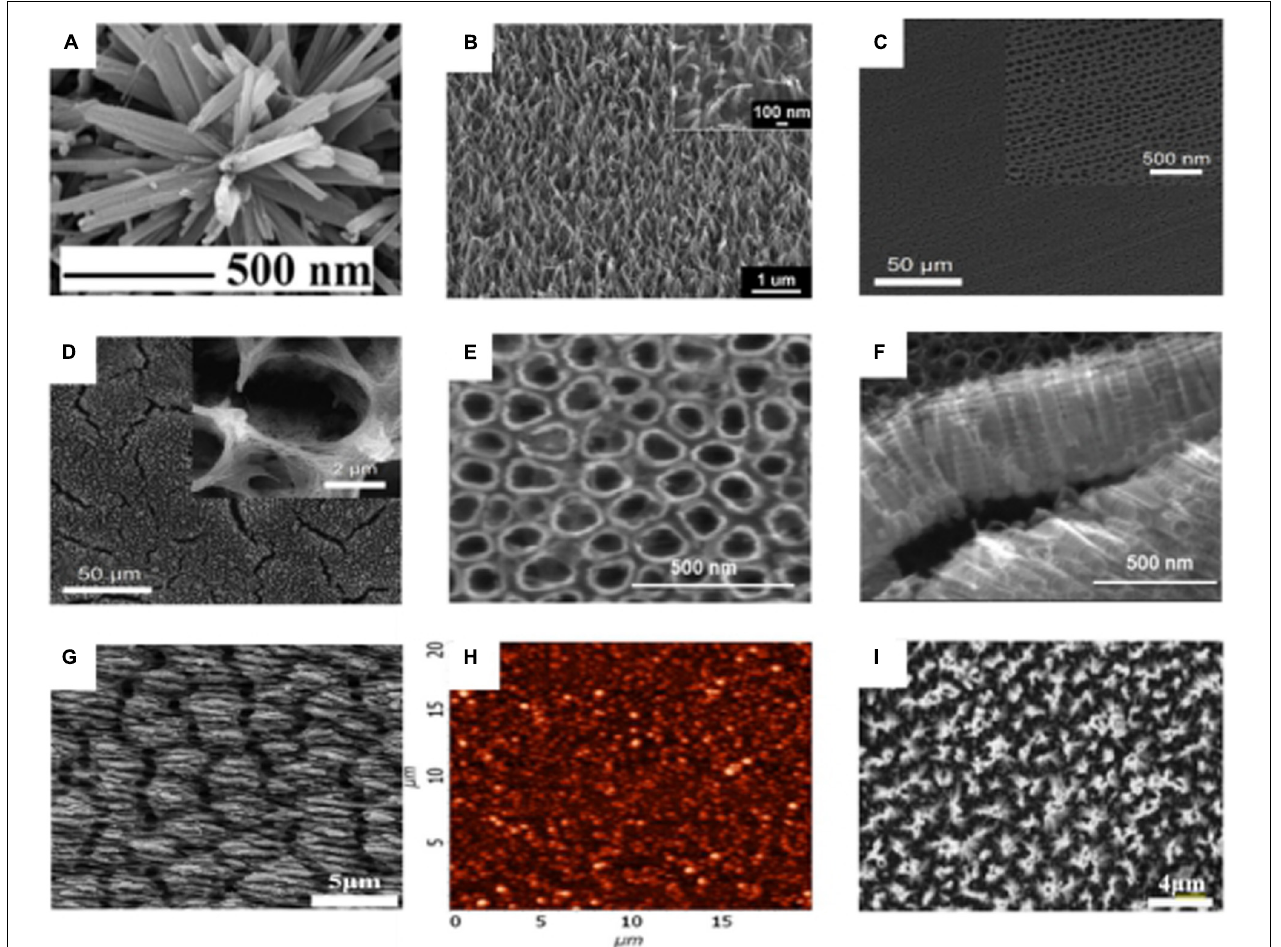
FIGURE 6 | SEM micrograph of different nano-morphologies on the surface of titanium substrate. (A) Nanoflowers (Vishnu et al., 2019). (B) Nanowires (Jaggessar et al., 2018). (C) Regular nanotubes (Rahnamaee et al., 2020). (D) irregular nanotubes (Rahnamaee et al., 2020). (E,F) nanotubes (Simi and Rajendran, 2017). (G) Nano-ripples (Luo et al., 2020). (H) AFM micrograph of NPs (De Falco et al., 2018). (I) nanopillars (Linklater et al.,